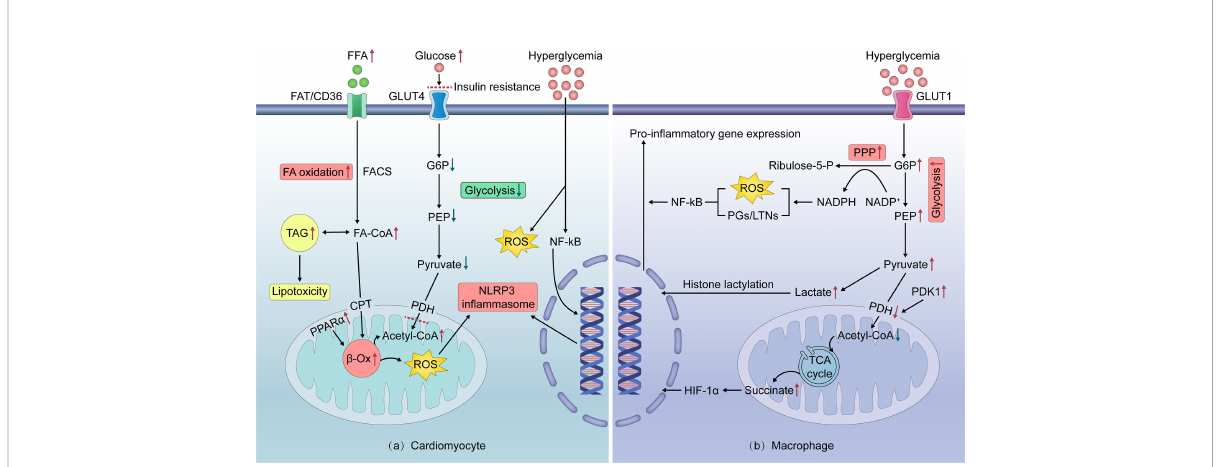
FIGURE 2 Intracellular mechanisms of cardiomyocyte and pro-in fl ammatory macrophage metabolic reprogramming in obesity. (A) In nutrient overloaded cardiomyocytes, excessive FFA intake activates PPAR a , thereby enhancing FA b -oxidation. This leads to excess ROS production, which activates the NLRP3 in fl ammasome to promote the secretion of in fl ammatory cytokines. Excess FA is stored as TAGs, which can mediate lipotoxicity. Increased FA oxidation contributes to cardiomyocyte IR by inhibiting GLUT4-mediated glucose uptake and utilization, resulting in cardiomyocyte exposure to high glucose levels. Hyperglycemia can induce ROS overproduction and directly trigger a series of pro- in fl ammatory pathways in cardiomyocytes. (B) In nutrient overloaded macrophages, glucose intake via insulin-independent GLUT1 and metabolism reprogram to rapid aerobic glycolysis. The product of glycolysis, lactate, increases histone lactation, thereby inducing the pro- in fl ammatory polarization of macrophages. Glycolysis also generates NADPH through the PPP, which promotes the production of ROS and supports proin fl ammatory prostaglandin/leukotriene synthesis, thereby activating NF-kB. In addition, enhanced glycolysis induces a truncated tricarboxylic acid cycle and succinate accumulation via decreased pyruvate entry into the mitochondria, which promotes HIF-1 a activation and pro-in fl ammatory gene expression. FA — fatty acid; FFAs — free fatty acids; FAD/CD36 — fatty acid translocase; TAG — triacylglycerol; FACS — fatty acyl-coenzyme A synthetase; FA-CoA — fatty acyl-coenzyme A; CPT — carnitine palmitoyltransferase; PDH — pyruvate dehydrogenase